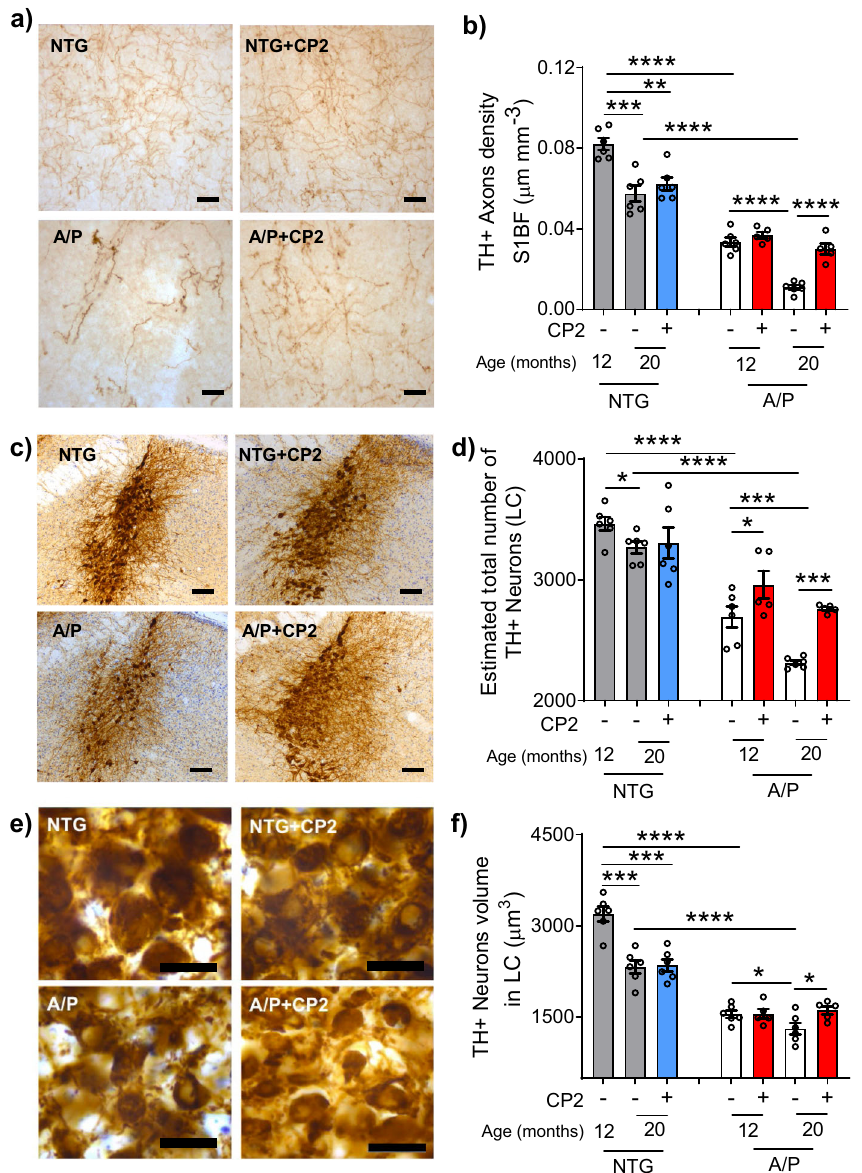
Fig. 7 CP2 treatment after the onset of AD-like neuropathology halts progressive degeneration of LC neurons in APP/PS1 mice. APP/PS1 and NTG mice were treated with CP2 or vehicle starting at 10 months of age. The animal brains were harvested at 12 (2 months treatment) or 20 months of age (10 months treatment) and evaluated for the integrity of the NAergic neurotransmitter system. a CP2 stops the progressive loss of TH + axons in the cortex of 20-month-old mice APP/PS1 mice. Representative images of TH + axonal projections in S1BF. Scale bar, 20 µ m. b The density ( µ m/mm 3 ) of TH + axons in S1BF was determined using stereological length estimation using spherical probe and images presented in a . Compared to NTG mice, APP/PS1 mice exhibit a signi fi cant progressive loss of TH + axons at 12 and 20 months of age. CP2 treatment prevented loss of TH + axons in APP/PS1 mice occurs between 12 and 20 months of age. c Representative image of TH + LC neurons in 20-month-old mice. Scale bar, 100 µ m. d CP2 stops the progressive loss of TH + neurons in APP/PS1 mice in LC. e Higher magni fi cation images from c were used to evaluate the relative sizes of neurons. Scale bar, 50 µ m. f CP2 stops the progressive loss of TH + neuronal volume in APP/PS1 mice at 20 months of age. n = 6 female mice per group. Data are presented as mean ± S.E.M. A two-way ANOVA with Fisher ’ s LSD post-hoc test was used to analyze the differences between APP/PS1 mice, and between untreated groups of NTG and APP/PS1 mice. A Student t -test was used to analyze the differences between untreated and CP2-treated NTG mice. * P < 0.05, ** P < 0.01, *** P < 0.001, **** P <